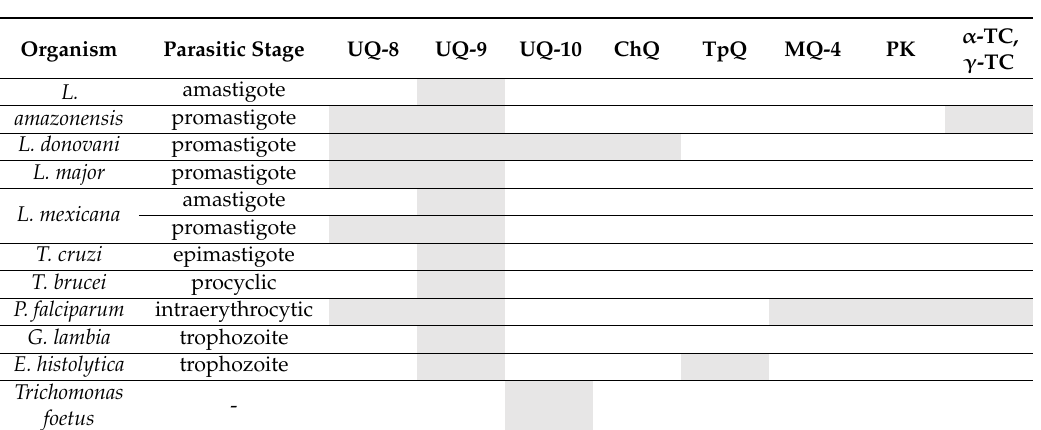
Table 3. Examples of the prenylquinone content in pathogenic protozoa. Table indicates in grey squares examples of previously characterized prenylquinones from pathogenic protozoa. White squares indicate still not characterized prenylquinones. All the prenylquinones are discussed in this review